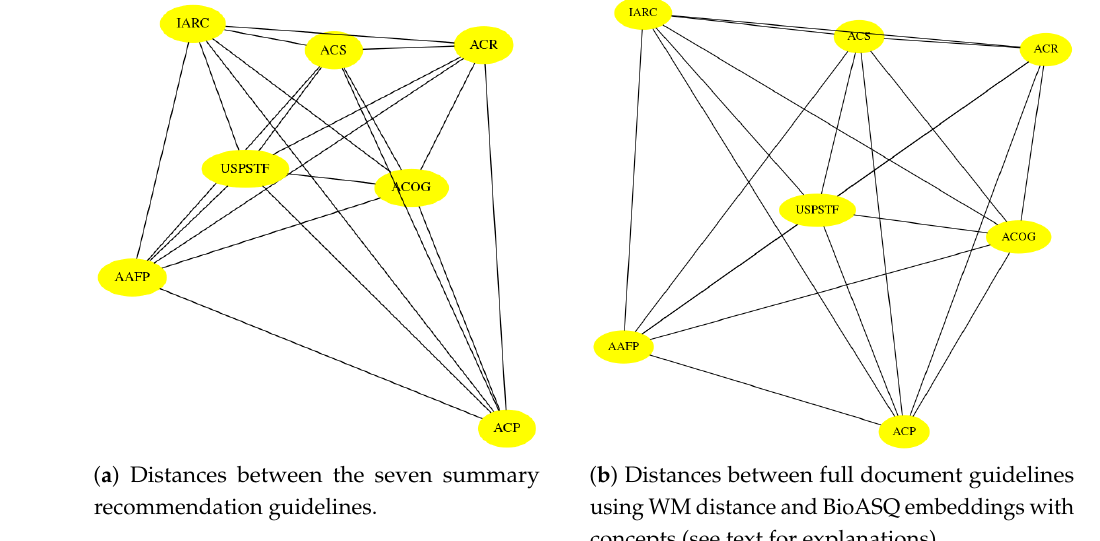
Figure 5. Visual comparison of a the similarity/distance graphs based on human analysis is shown in panel ( a ), and computer generated comparison from Table 5 is shown in panel ( b ), which suggest a similar geometry. As we rigorously show in Section 6, this 69% similarity is not accidental ; the distortion is about 31%. Notice that we are not pointing to the actual locations of similarities and difference in the guideline documents. Instead, we are pointing to global (latent) differences stemming from concepts appearing in them.